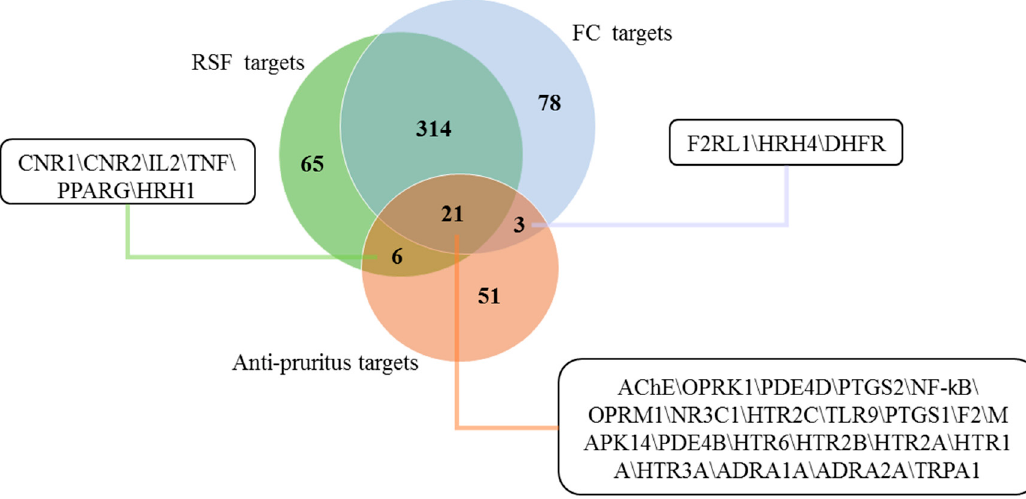
Figure 3. Putative anti-pruritus targets of RSF and FC. Venn diagram for putative targets of RSF and FC and known anti-pruritus targets. The list of targets in the intersection sets.